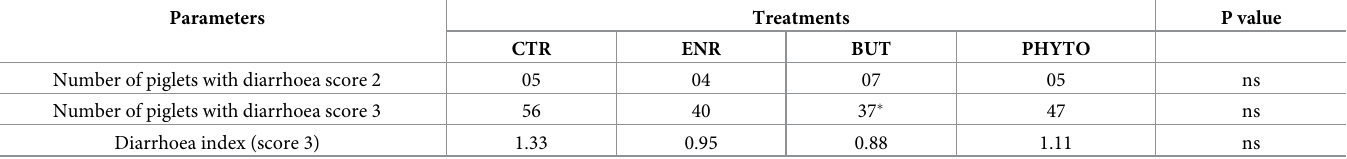
Table 4. Effects of in-feed supplementation with enramycin (ENR), encapsulated sodium butyrate (BUT) and dry herbs plus essential oils (PHYTO) on the diar- rhoea incidence and diarrhoea index of light weaned piglets during the nursery phase.